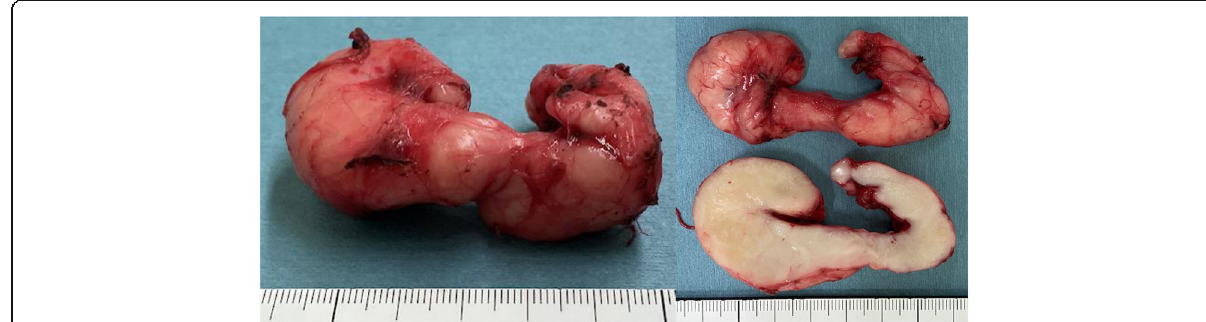
Fig. 6 The resected specimen. The tumor was resected completely without injuring the surrounding structures. The image shows the tumor ’ s irregular and complicated